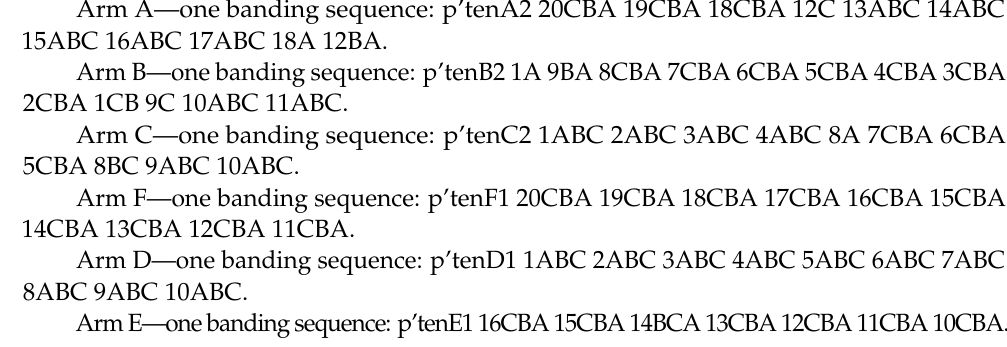
Figure 4. Karyotype of Camptochironomus tentans from Kurchatskoe Lake, Tyumen reg., Russia. Ar- rows indicate centromeric bands; p’tenA2, p’tenB1, etc., genotypic combinations of banding sequences in chromosome arms; BR, Balbiani rings; N, nucleolus; and prefix p’ for Palearctic se ‐ quences.